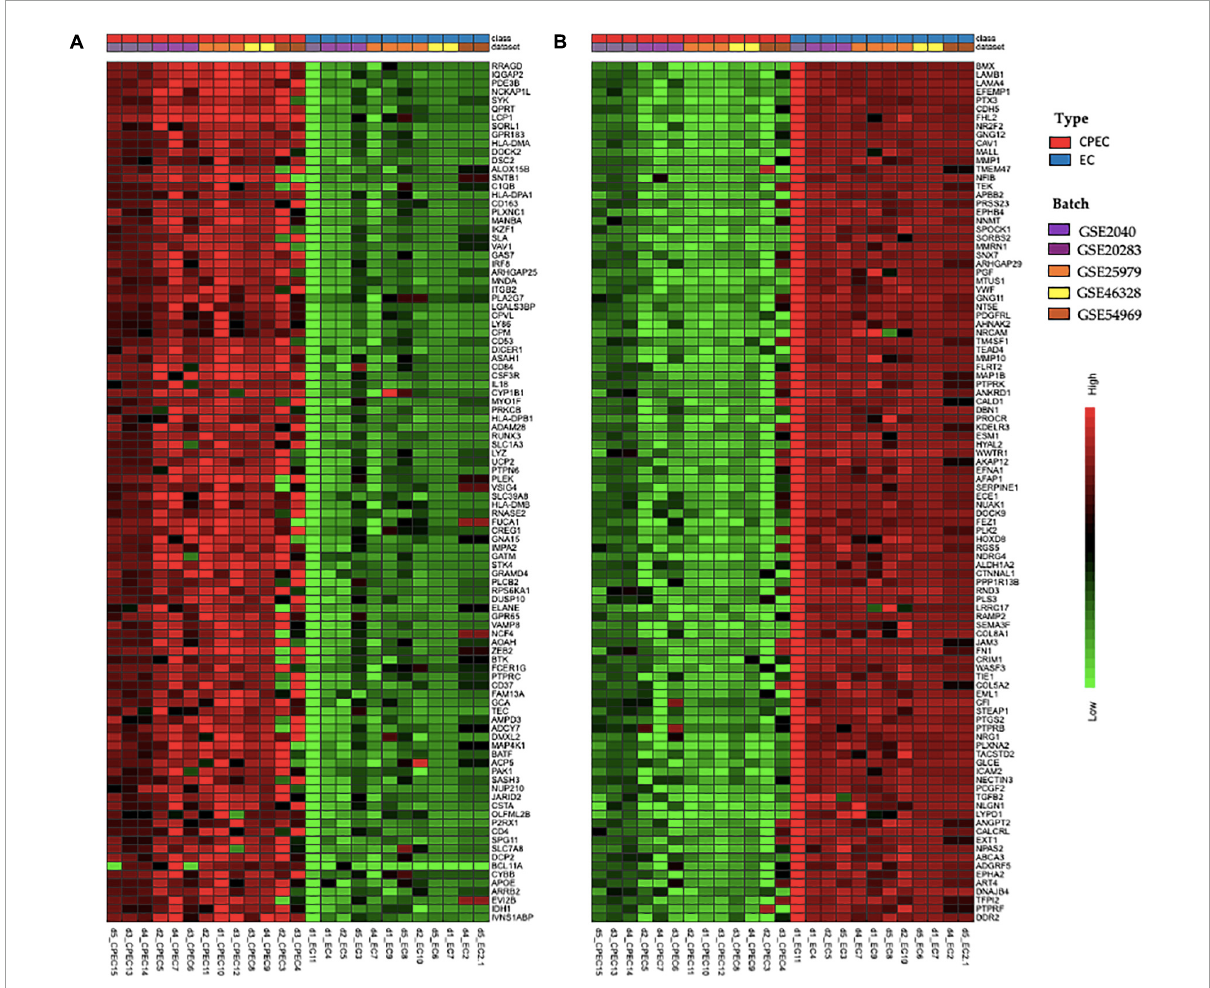
FIGURE3 Hierarchical clustering of top 100 up-regulated DEGs (A) and top 100 down-regulated DEGs in EPCs (B) . Green and red color represent z-score expression levels, light green is the lowest and dark red is the highest value. Samples were grouped by type (EPCs and ECs) and batch. Genes were clustered by Ward